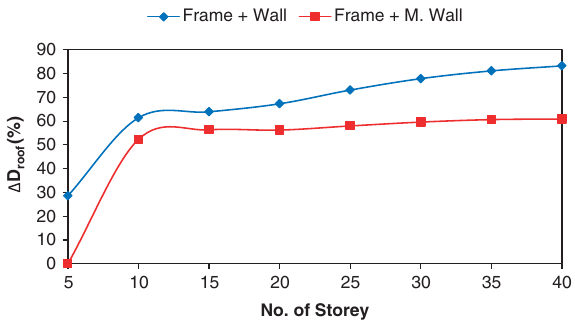
Fig. 10. Increment of natural frequency, Δ f n , for masonry walls inclusion